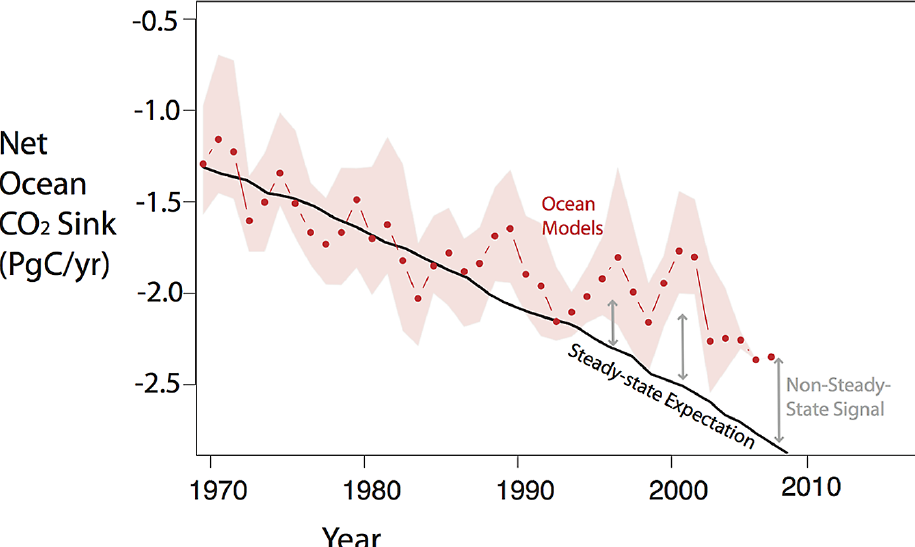
Fig. 1. Illustration of the time-evolving net CO 2 uptake from the ocean since 1970 comparing the expected steady state uptake that assumes constant circulation and biology (black line) with the mean net uptake from five different ocean models that include time-evolving natural forcings (Wetzel et al., 2005; Le Qu´er´e et al., 2007; Lovenduski et al., 2007; Matear and Lenton, 2008; Rodgers et al., 2008). We include the results from the hindcast CSIRO climate model from Matear and Lenton (2008) and the suite of model projections documented in Sarmiento et al. (2010). The expected steady state CO 2 uptake is taken from Mikaloff-Fletcher et al. (2006) as documented by Sarmiento et al. (2010), normalized to the decade of 1970–1980. The average net CO 2 uptake (red dots) was taken as a combined mean between the five different models with minimum and maximum bounds shaded in light red. This is an illustrative figure used to demonstrate the time-evolving changes in the various CO 2 signals within the ocean as described in Eq. 4. The integrated dotted red curve is the total net CO 2 uptake by the ocean ( 1 DIC Net ), which is about 36PgC between 1989 and 2007. The black curve is the expected steady state CO 2 uptake or what has been historically called anthropogenic CO 2 uptake ( 1 ACO 2 ), which is about 42PgC between 1989 and 2007. The difference between 0 + 1 DIC 0 these curves is therefore the combined non-steady state CO 2 loss to the atmosphere ( 1 ACO ), which comes to about 6.3PgC Nat 2 outgassing to the atmosphere between 1989 and 2007 (see Table 2 of Sarmiento et al.,